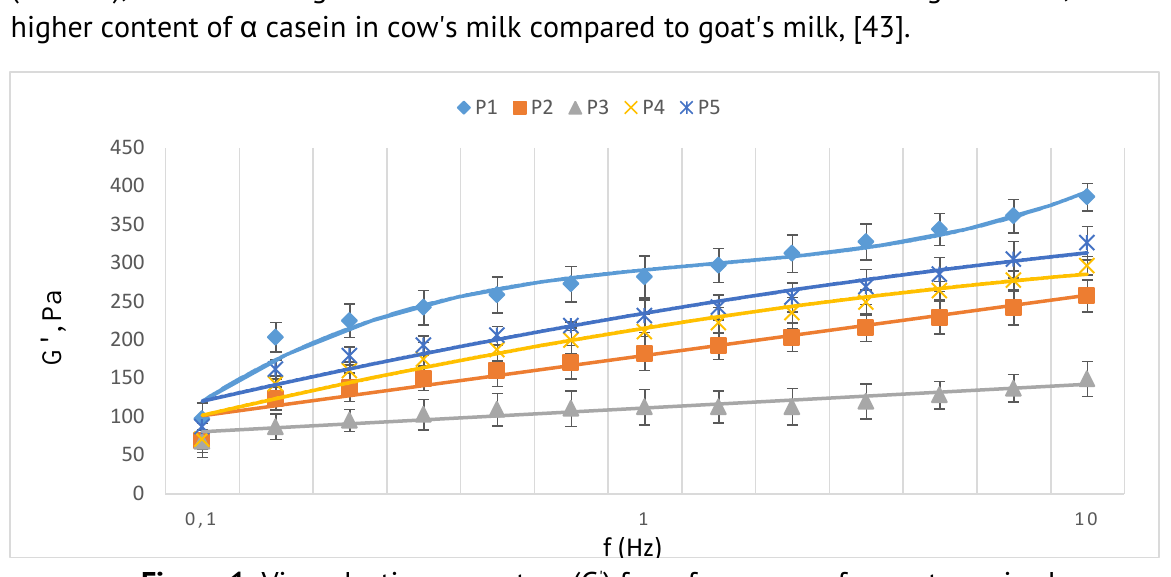
Figure 1. Viscoelastic parameters (G ' ) from frequency of yogurts, series